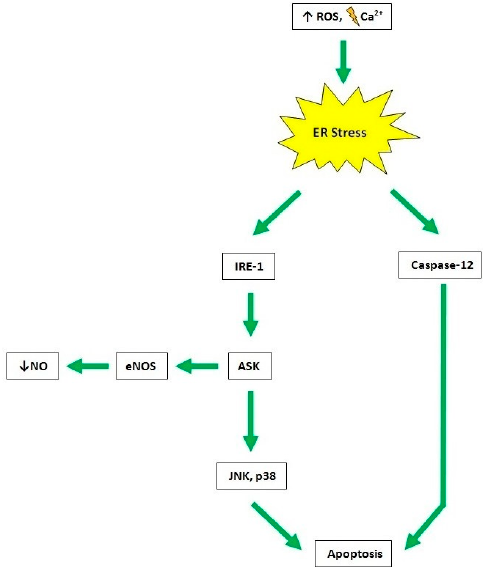
Figure 3. ER stress. The increased ROS levels or insulin resistance lead to ER stress in endothelial cells. While insulin resistance altered the production of NO, the reduced bioavailability of NO induces an increase of oxidative stress leading to an impaired calcium homeostasis and to the activation of proapoptotic signals such as JNK / p38 or caspase-12 promoting apoptosis. IRE-1 through the apoptotic signal ASK1 stimulates proapoptotic signals. Moreover, ASK1 decrease eNOS levels and causes NO